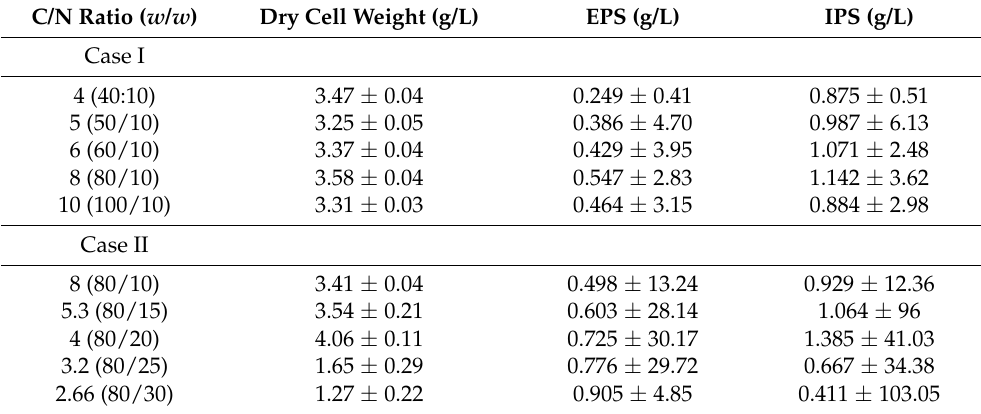
Table 2. Effect of different C/N ratios on mycelial biomass and polysaccharides production when sucrose and yeast extract were used for T. borchii submerged